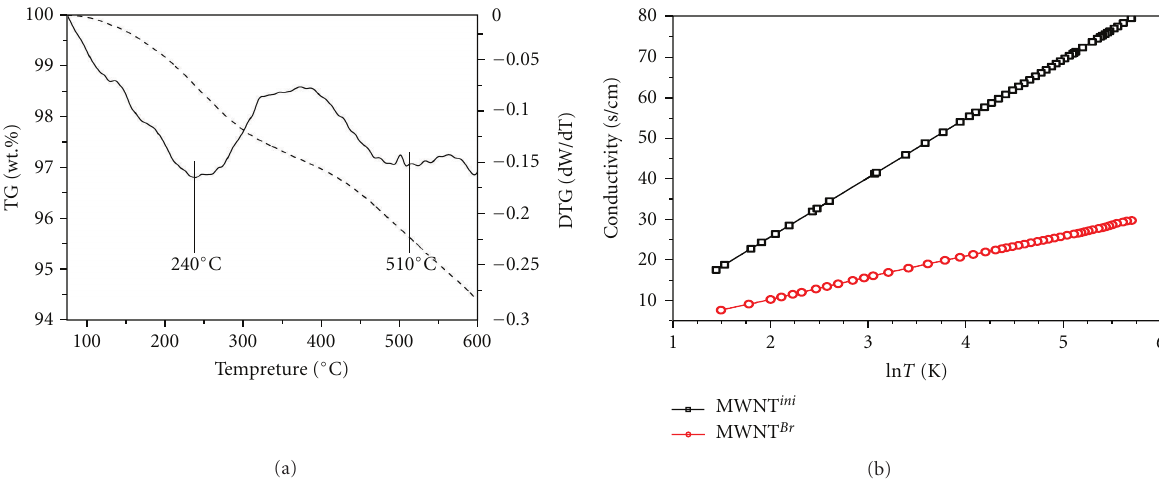
Figure 4: (a) Thermal analysis data for MWNT Br sample in nitrogen atmosphere at 10K/min (solid line represents di ff erential thermal data, dashed line represents thermogravimetric data); (b) temperature dependencies of electrical conductivity for initial and brominated